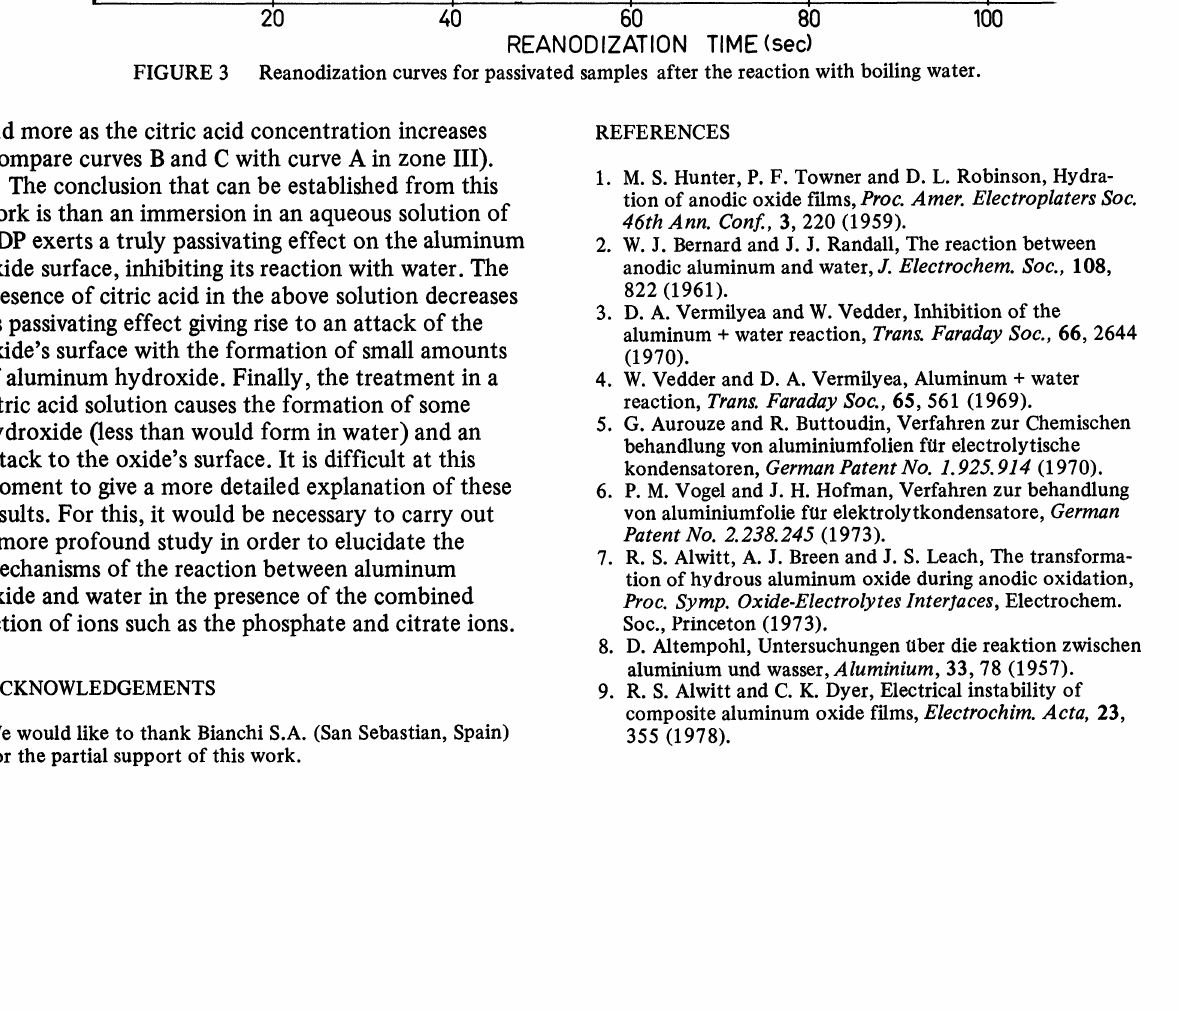
20 40 100 REANODIZATION TIME (sec) FIGURE 3 Reanodization curves for passivated samples after the reaction with boiling